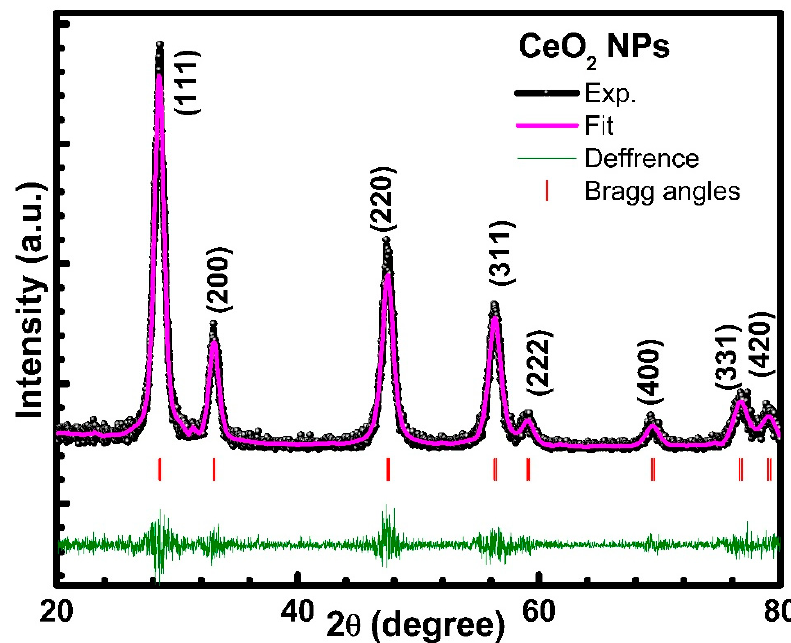
Figure 1. XRD patterns of CeO 2 NPs at room temperature. The spectral lines marked by the black sphere represent the experimental curve while the fine purple line indicates the calculated spectra. The green line represents the difference between experimental and fitting spectra. The location of Bragg’s positions is demonstrated by the red lines seen in Figure 1. The goodness factor of the fitting ( χ 2 ) was found between ~0.4. It can be seen from Figure 1 that the Bragg’s positions observed at 28.46 ◦ , 33.04 ◦ , 47.43 ◦ , 56.32 ◦ , 59.23 ◦ , 69.32 ◦ , 76.67 ◦ , and 79.12 ◦ correspond to Miller planes (111), (200), (220), (311), (222), (400), (331), and (420), respectively. All the planes observed in the XRD pattern are successfully indexed to possess face-centered cubic (FCC) crystal structure with a space group Fm-3m (JCPDS card no.75-0151) [32,33] and observed peaks are